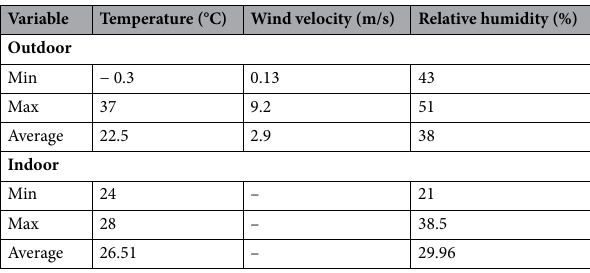
Table 1. Temperature, relative humidity and wind speed.